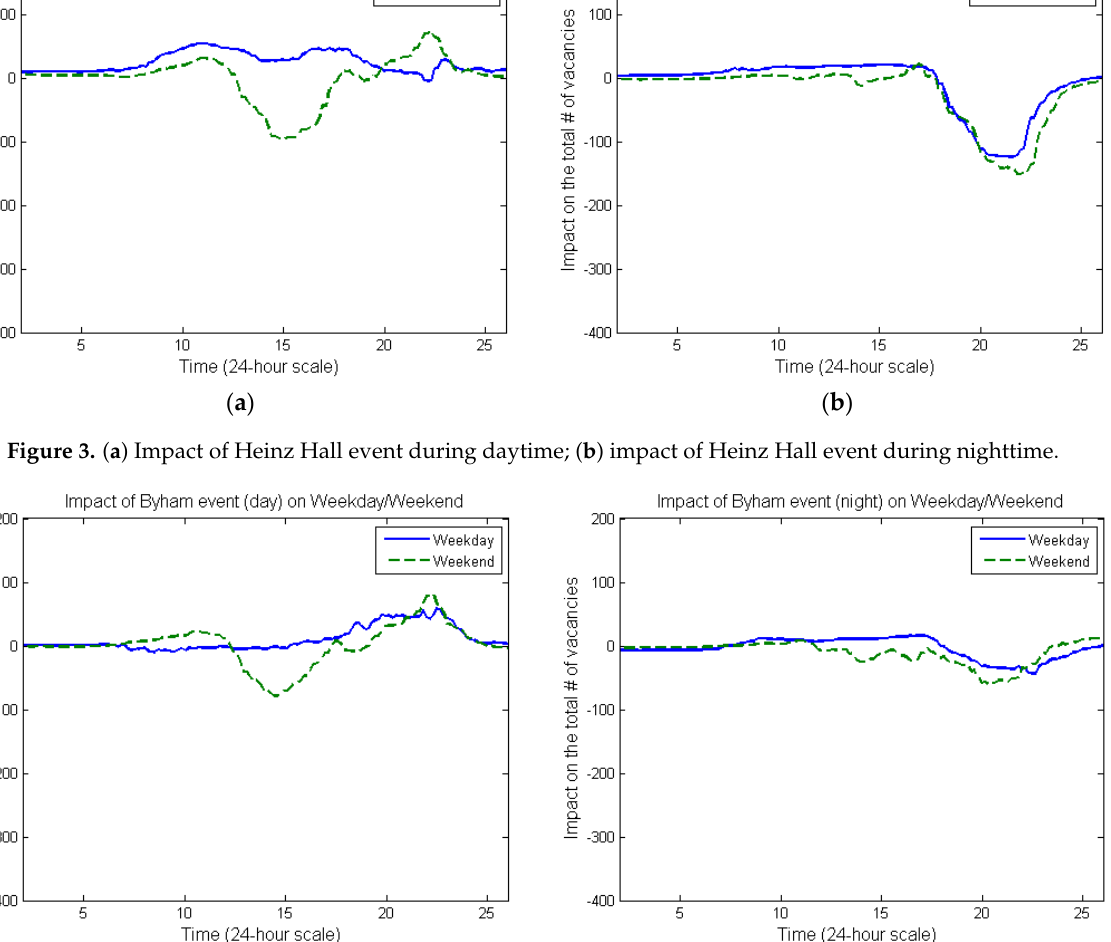
( a ) ( b ) Figure 5. ( a ) Impact of Benedum Center event during daytime; ( b ) impact of Benedum Center event during nighttime. Figures 3a, 4a, and 5a show that the impacts of daytime events were more or less negligible on weekdays, while the impacts of daytime events were larger in magnitude at around 3 p.m. on weekends/holidays. Figures 3b, 4b, and 5b show the impacts of nighttime events, which were larger in magnitude at around 9 p.m. on both weekdays and weekends/holidays. It is interesting to observe that the magnitude of the peak impact was more or less consistent: For example, Figure 5a shows that the peak impact of Bene- dum daytime event on weekends was around − 250 at 3 p.m., which is similar to the peak impact of Benedum night events on weekends/weekdays at around 9 p.m. This peak im- pact of Benedum event—a reduction of 250 available spaces (about 32% of the total capac- ity 785)—is relatively large since the average number of remaining spaces was around 300 (about 38% of the total capacity) during these peak times (see Figure 2a). We observed that the impacts of events were not only determined by the capacities of event venues, but also strongly affected by their distances to the Theater Square Garage. For example, the capacity of Heinz Field is approximately 24 times bigger than the capac- ity of Benedum Center (see Table 1). However, the impact of Heinz Field is less than twice of the impact of Benedum Center because Benedum Center is much closer to the Theater Square Garage than is Heinz Field. Another reason is the limited capacity of the facility. It is thus noted that the impacts of events we observed in this study were facility-specific